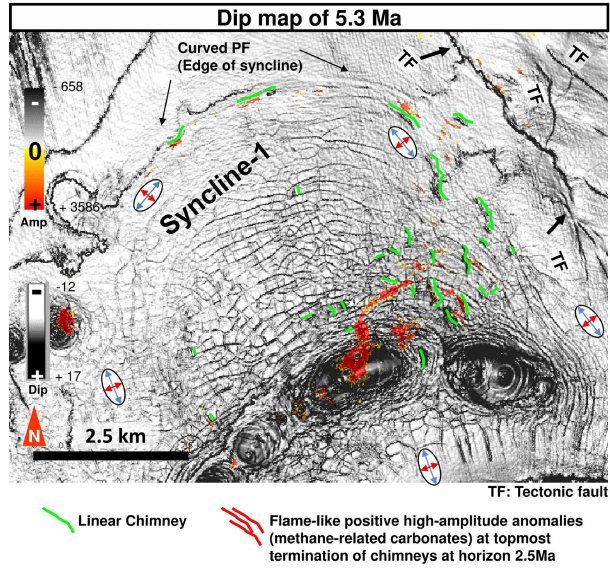
Figure 11. Dip map of key horizon 5.3Ma (base of PF Tier-2) showing the distribution of Linear Chimneys in Syncline-1. Iso- lated positive high-amplitude anomalies (PHAAs) at the topmost terminations of Linear Chimneys at horizon 2.5Ma (interpreted as methane-related carbonates) are superimposed on the dip map. Green lines highlight the locations of Linear Chimneys underlying the carbonate. Red amplitudes are flame-like PHAAs. The blue axis and red axis on stress ellipses indicate the palaeo-orientation of the intermediate and minimum stresses,